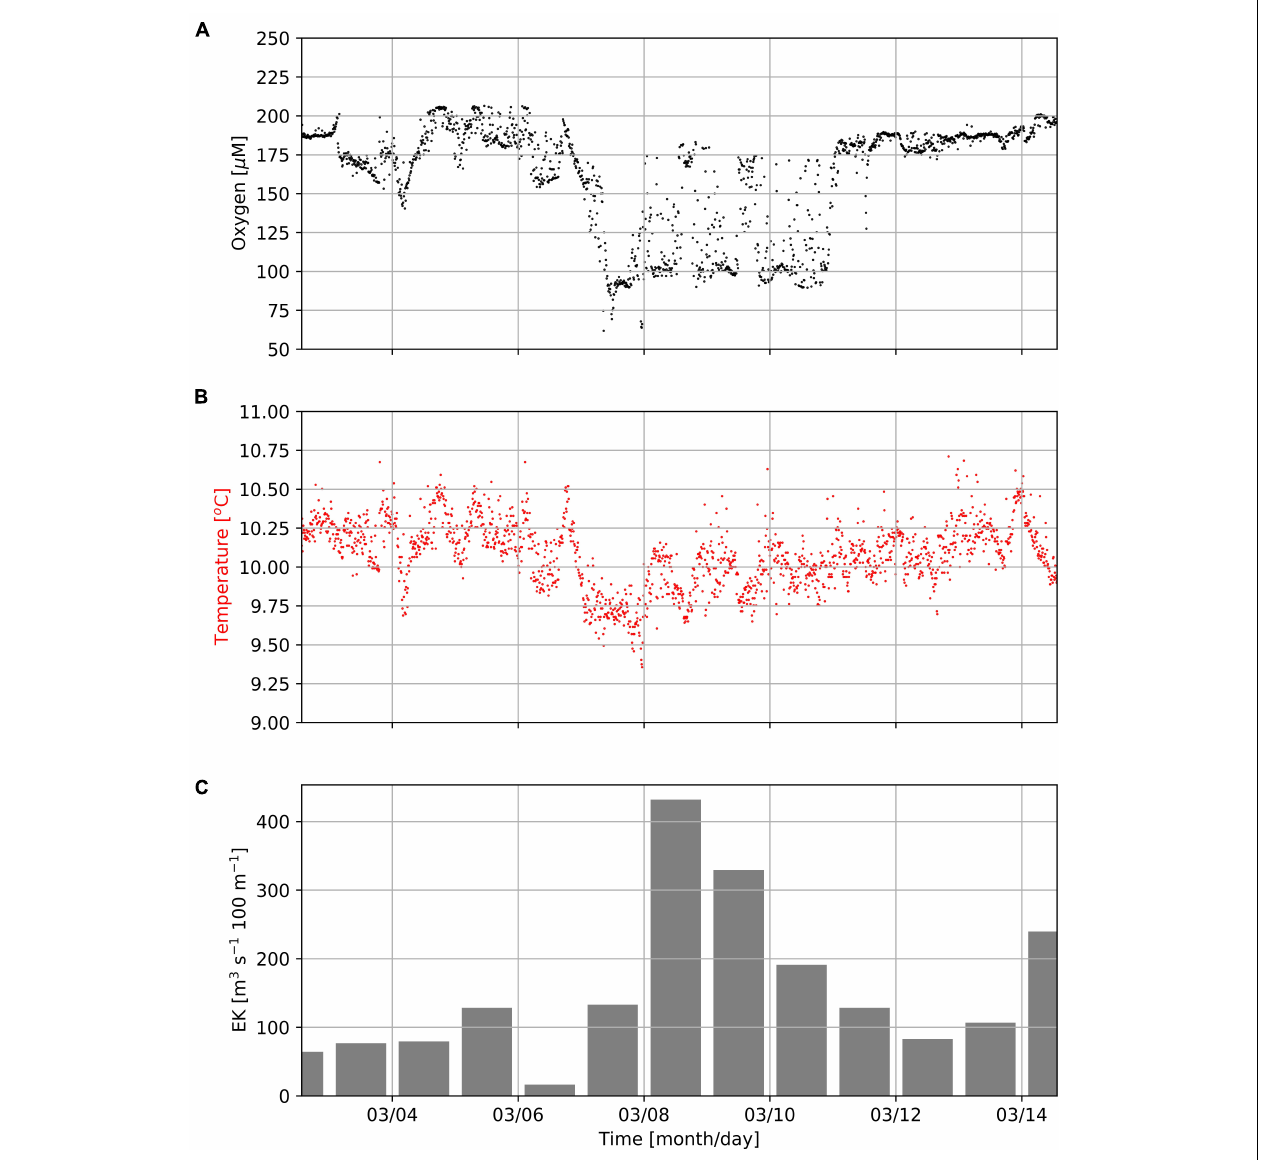
FIGURE 7 | Concentrations of dissolved oxygen (A) and seawater temperature (B) measured by the MDO sensor at the mooring site ( Figure 1 ) in a water-depth of 96 m as well as daily Ekman Transport indices (EK, C ) as computed according to Lamont et al. (2018) during the first half of March 2019. Positive EK values indicate offshore